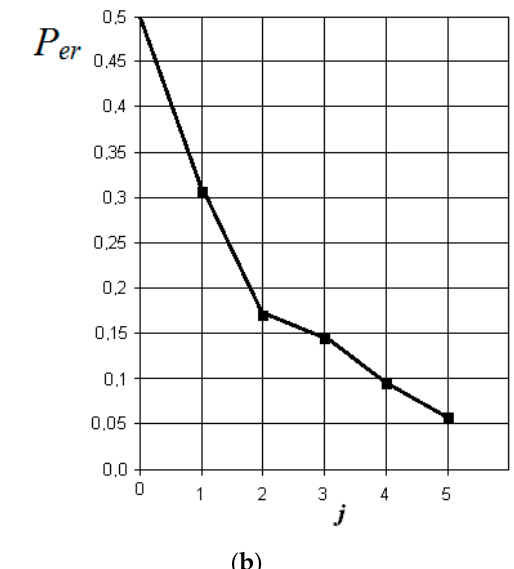
Figure 6. The results of discriminant data analysis when comparing the norm with acute serous odontogenic sinusitis: ( a ) the dependence of the increase in the normalized Euclidean distance as signs are added to the discrimination model F(j)   ; ( b ) the dependence of the decrease in the probability of a decision error as signs are added to the discrimination P f(j)  : j = 5 is the dimension of the space of informative parameters. model er